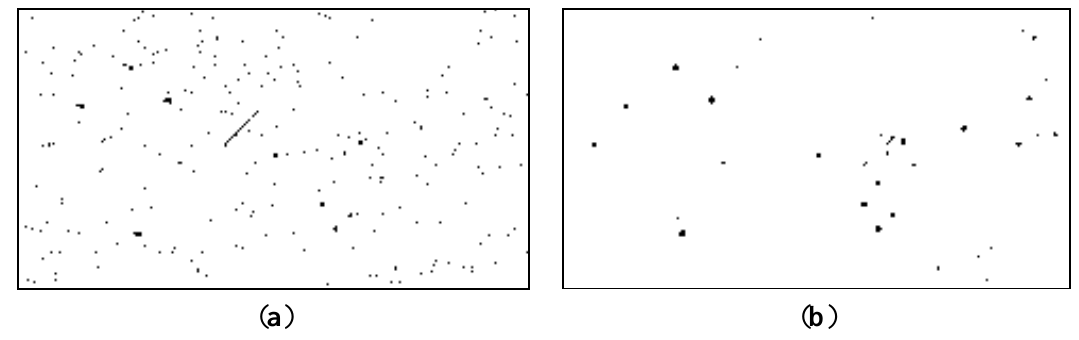
Figure 8. The foreground star mask ( a ) and the background star mask ( b ).